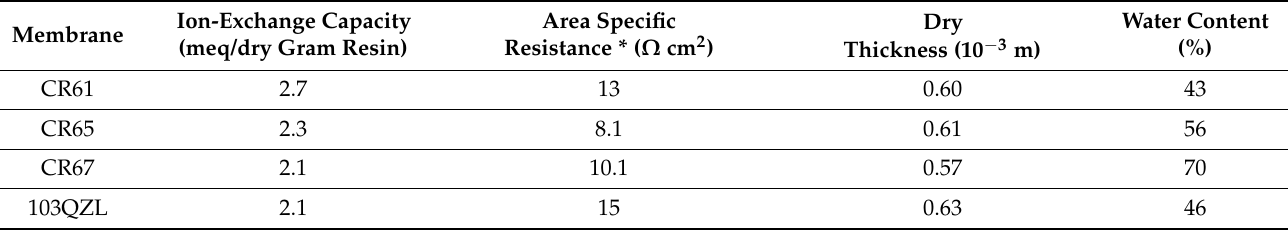
Table 1. Properties of selected commercial membranes.